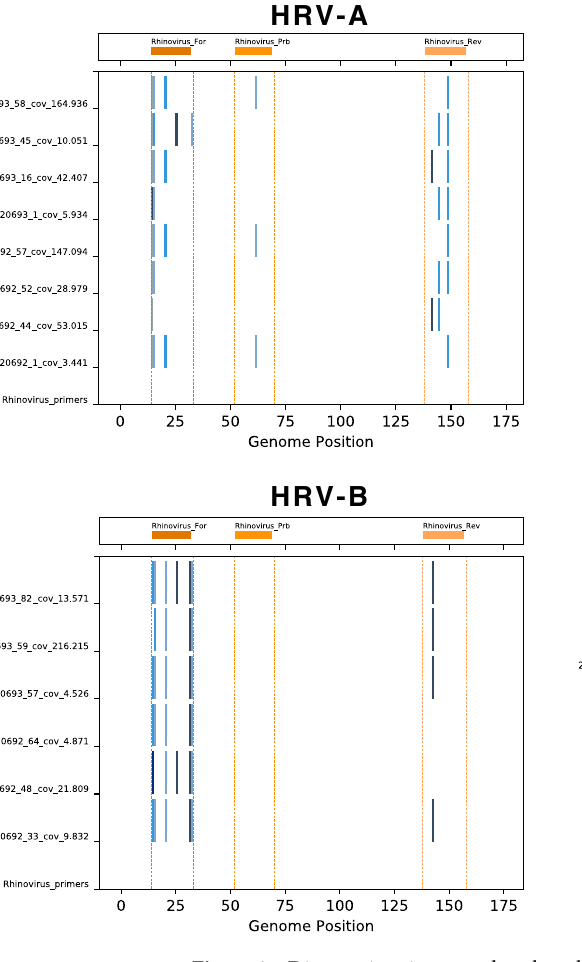
Figure 2. Diagnostic primers and probes check for human rhinoviruses (HRV) and human parainfluenza virus identified from the study. The diagnostic primers and probes target sites in the Kilifi HRV-A, HRV-B, HRV-C and HPIV-1 genomes were examined (see Fig. 1 legend for detailed methods). For each contig, nucleotide changes from the expected target sites were indicated by vertical blue lines, gaps in the sequence were indicated by grey